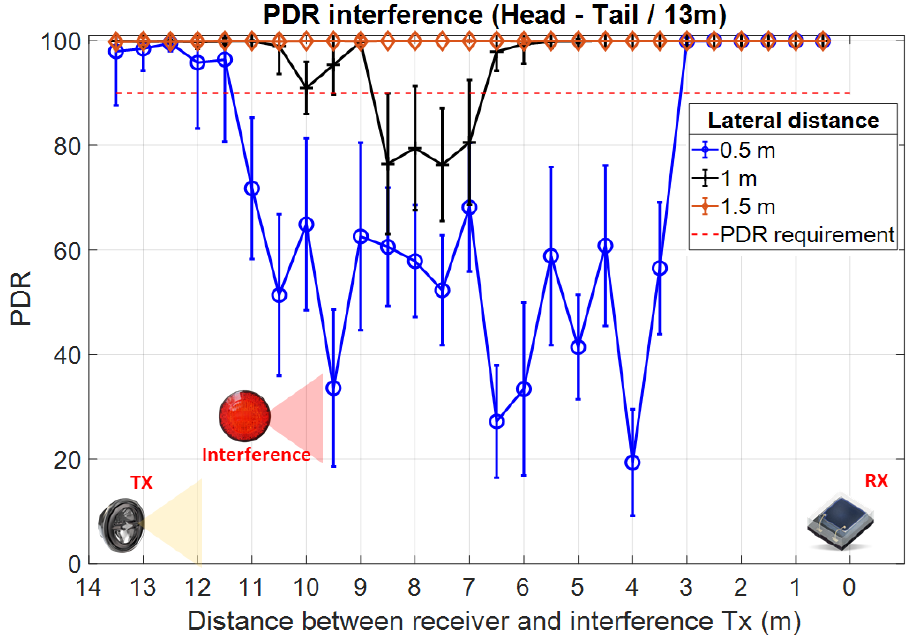
Figure 14. Experimental results showing the interference effect when intended headlamp transmitter is located at 13 m from the intended receiver, whereas the interference transmitter (tail-light) located at lateral distances of 0.5, 1, and 1.5 m, moves longitudinally from 0 to 13 m.